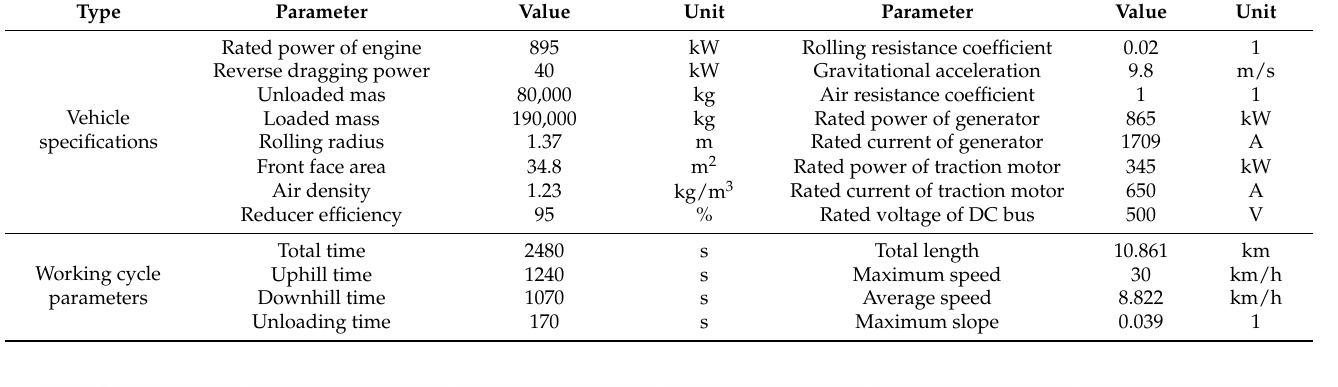
Table 1. Parameters in Working Cycle Test of the Mining Truck.